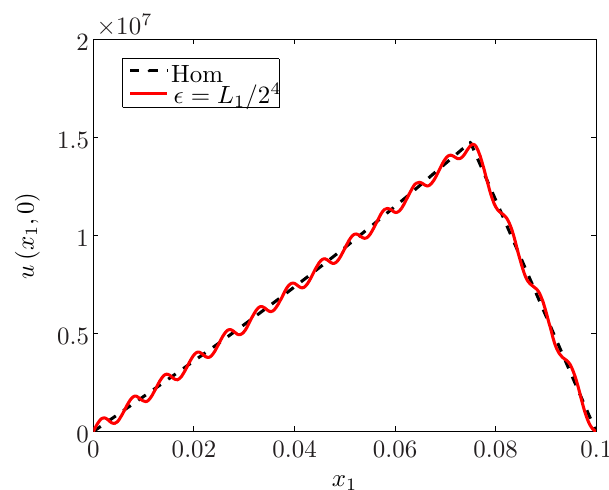
Figure 3. Homogenized and deterministic non-Newtonian pressure solutions along the line x 2 = 0